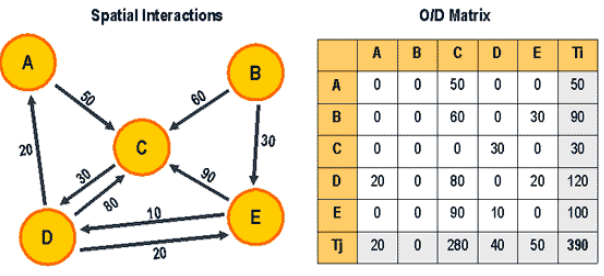
Figure 3. An example of network cost and OD matrix